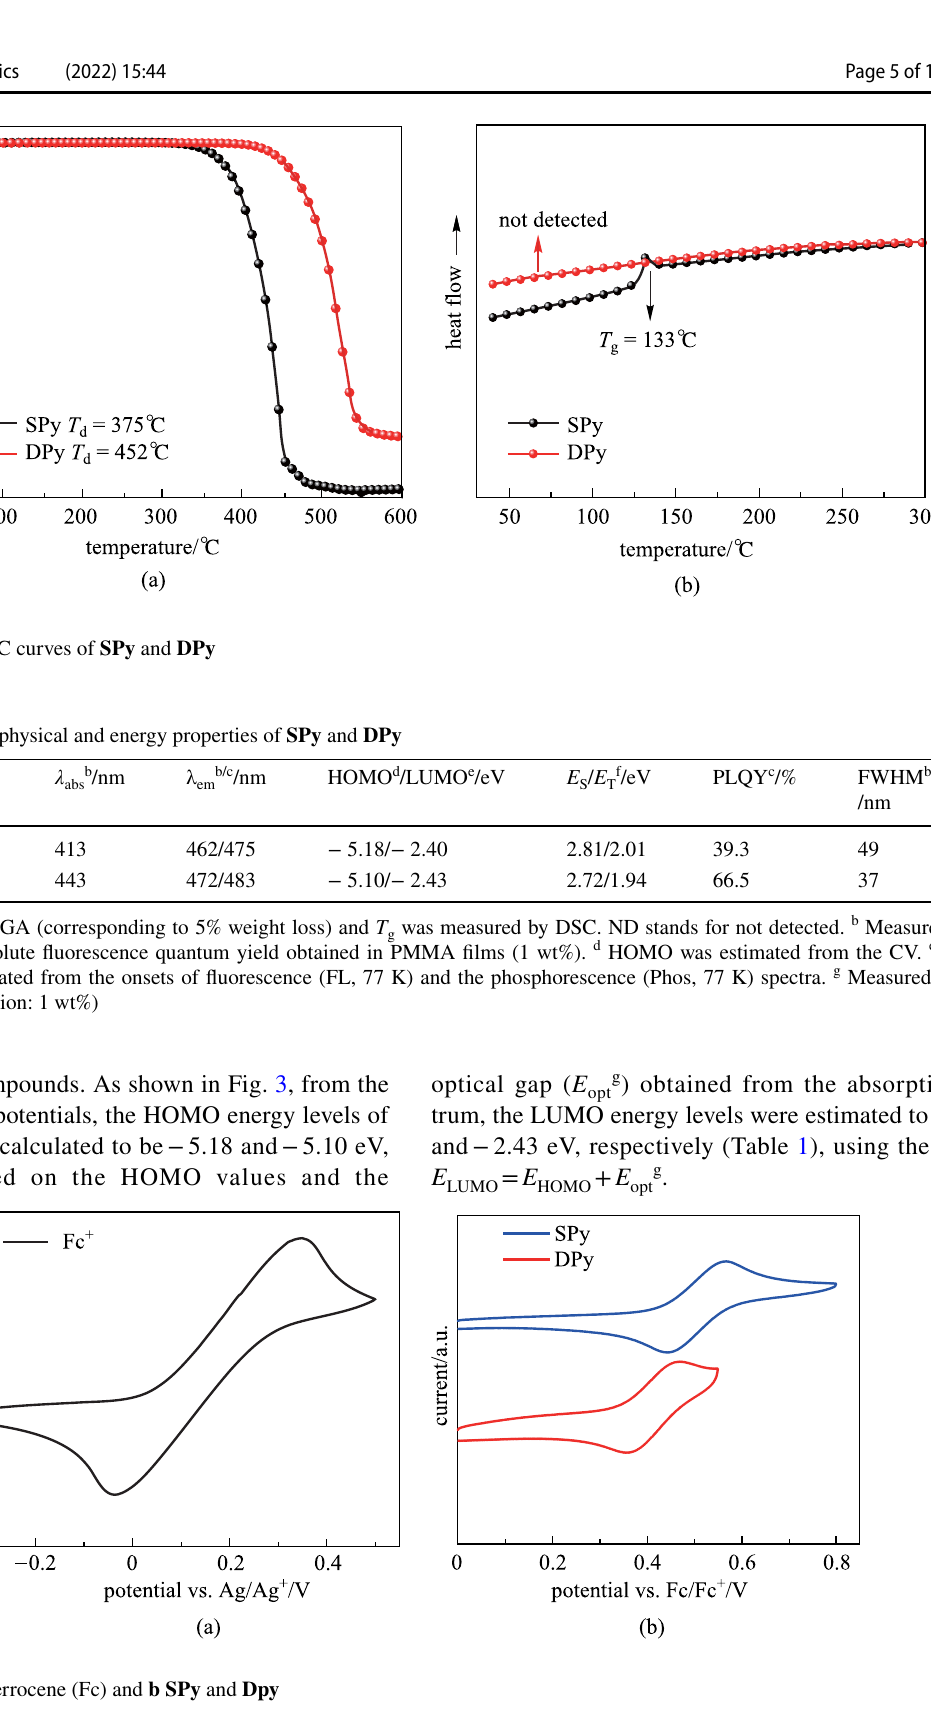
Fig. 3 CV curves of a ferrocene (Fc) and b SPy and